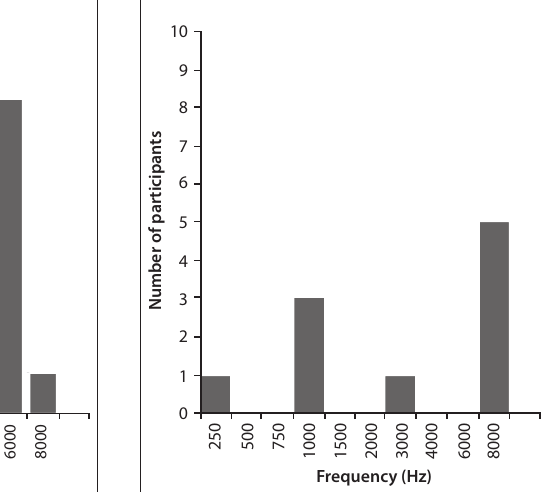
Fig. 1. Tinnitus pitch matching for group A (TMD group).